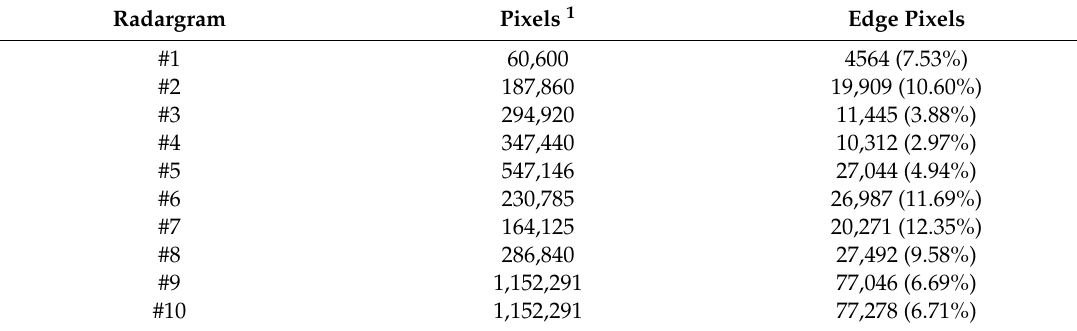
Table 2. Number of edge pixels found in the Canny-processed